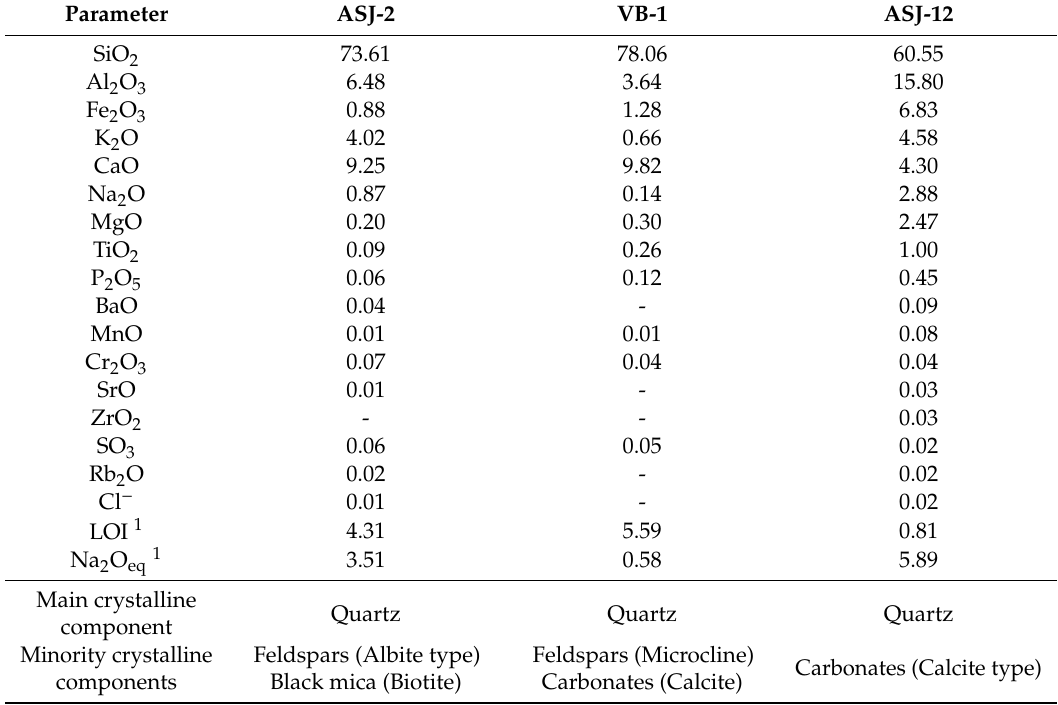
Table 3. Chemical composition for the three tested aggregates: ( a ) non-reactive siliceous sand, ASJ_2; ( b ) siliceous gravel with moderate reactivity, VB; ( c ) high-reactive siliceous pebbles,